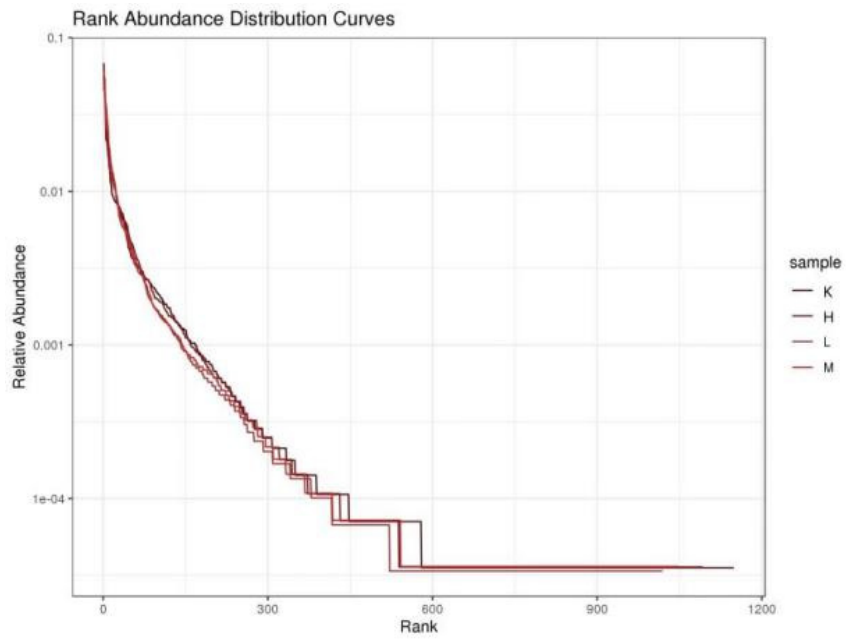
Figure 4. Species Abundance Rank Curve.